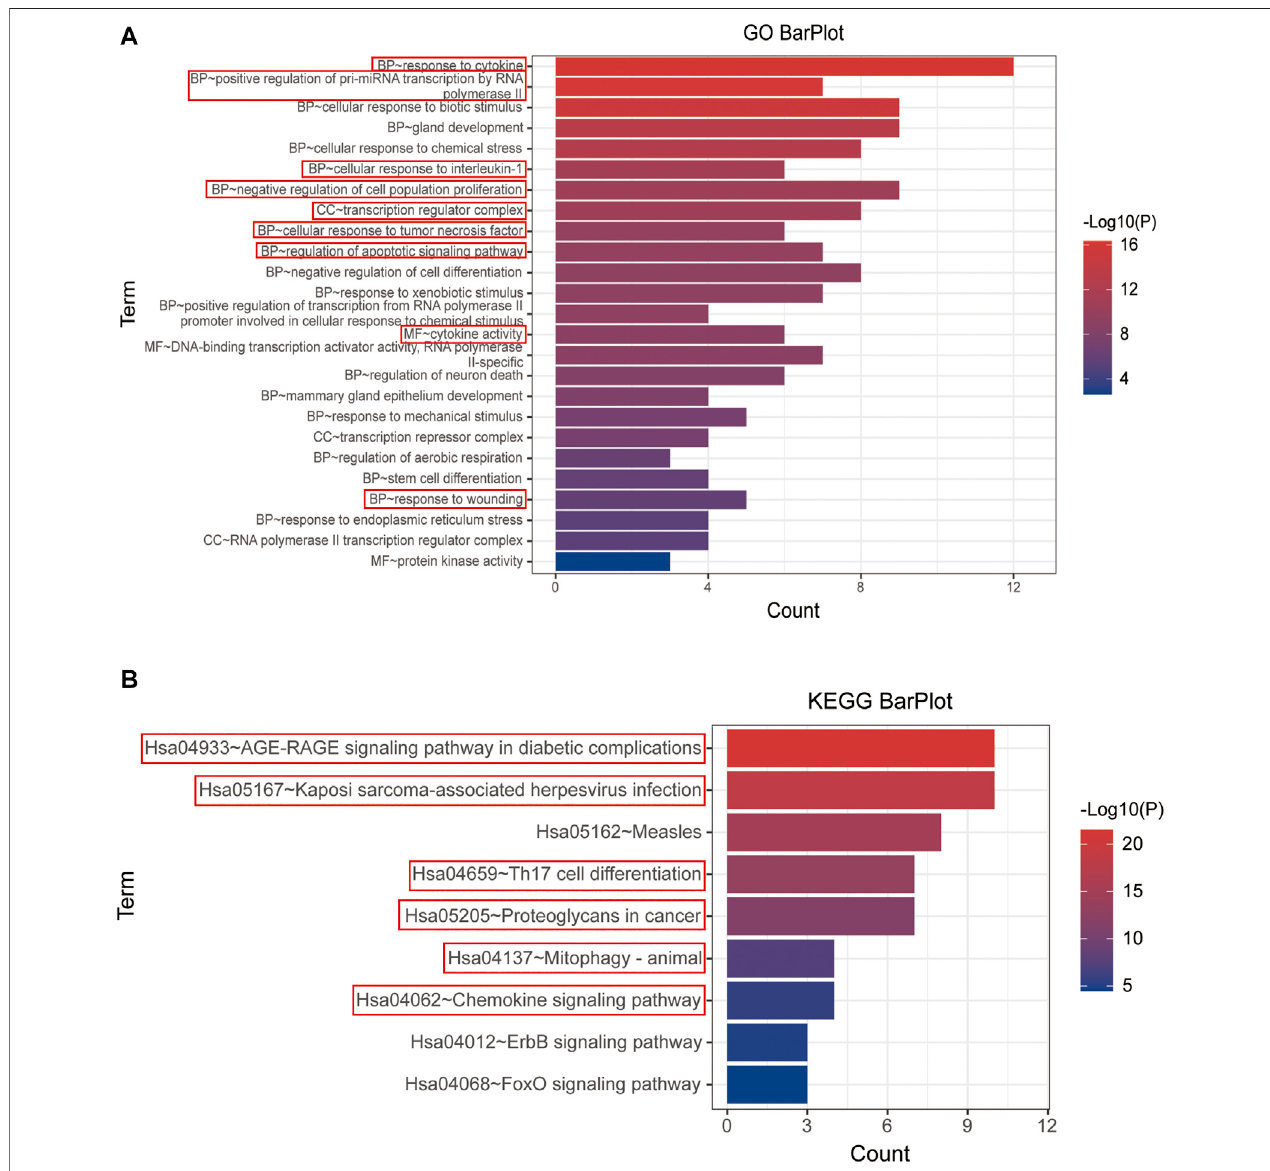
FIGURE 5 | GO enrichment of 15 top genes extracted from PPI network (A) . BP: biological process, CC: cell component, and MF: molecular function. KEGG enrichment of 15 top genes extracted from PPI network (B) . The items marked with red boxes represent the very important GO processes and KEGG pathways that directed to further